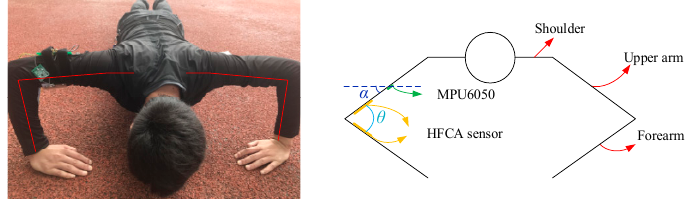
Figure 9. The detection model of push-ups.